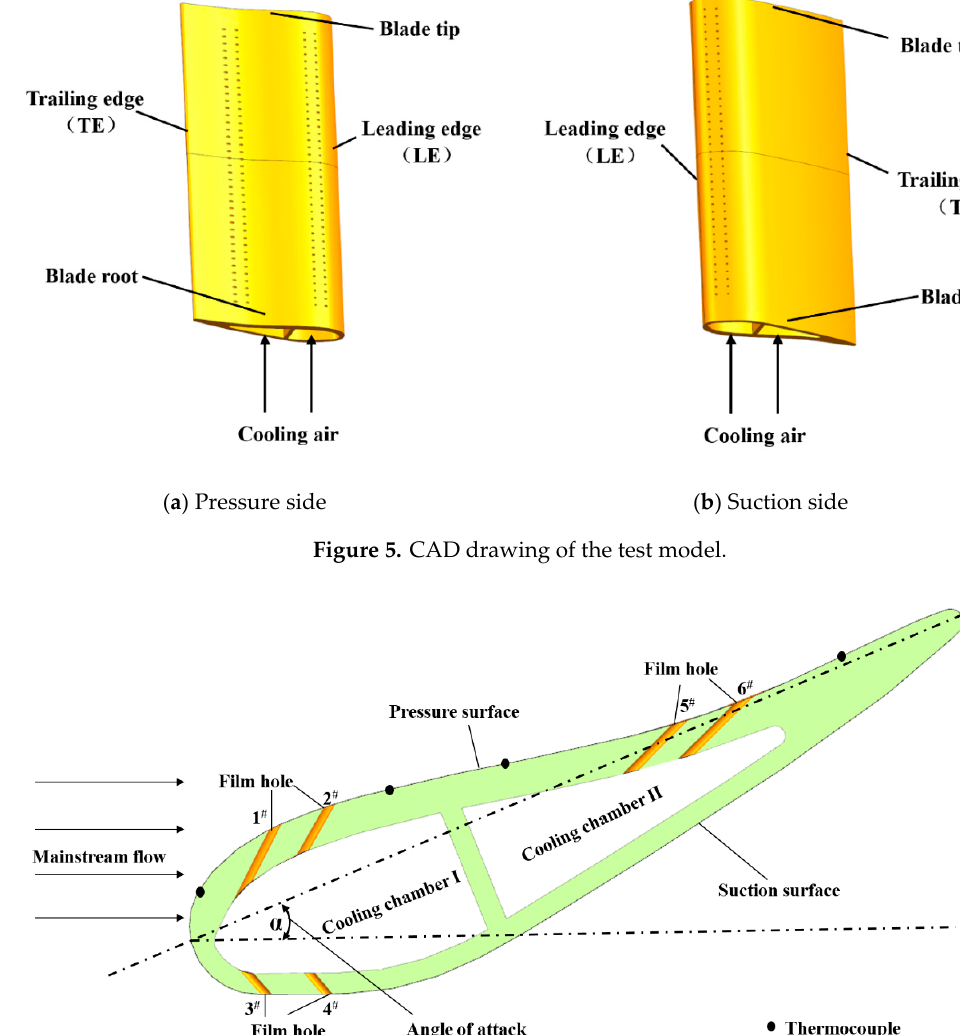
Figure 7. Photograph of the test sand.